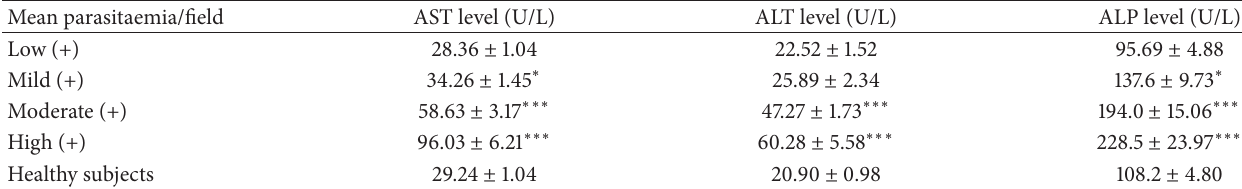
Table 5: Mean liver enzymes levels in parasitaemia P. falciparum malaria and healthy control subjects.